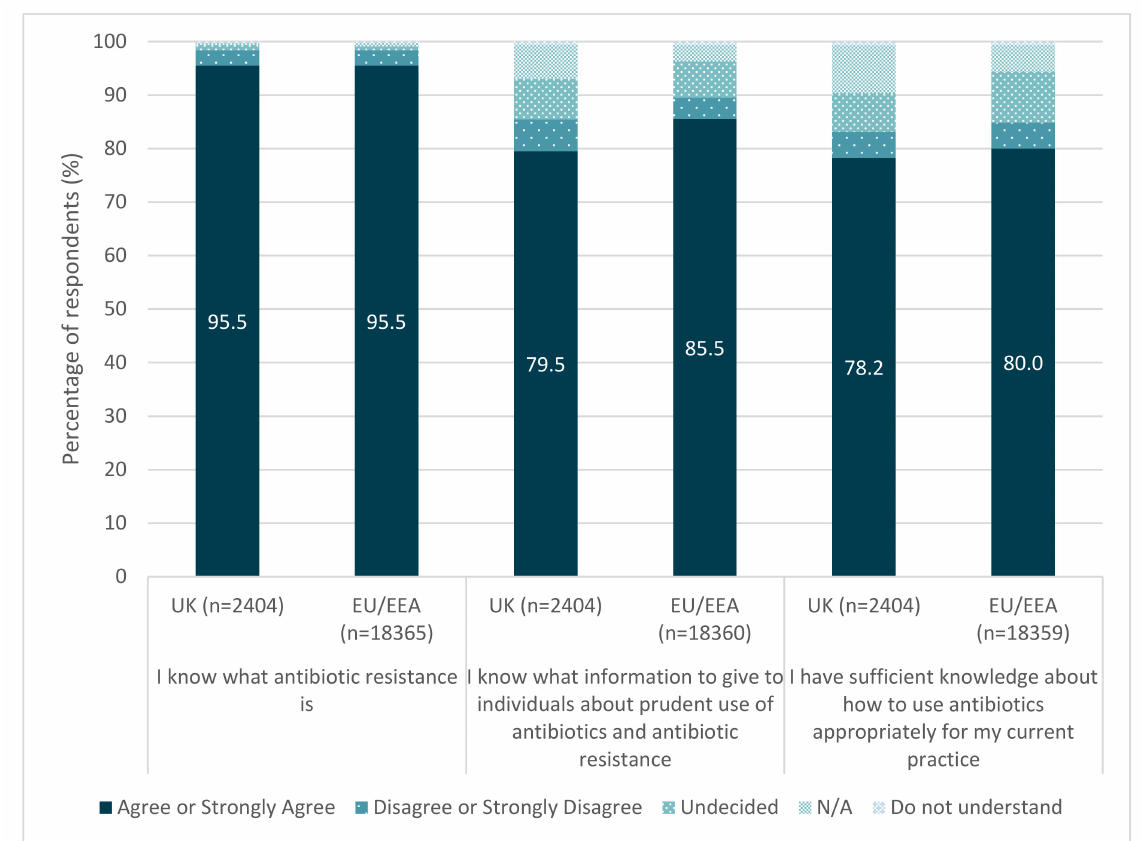
Figure 1. UK respondents’ perceived